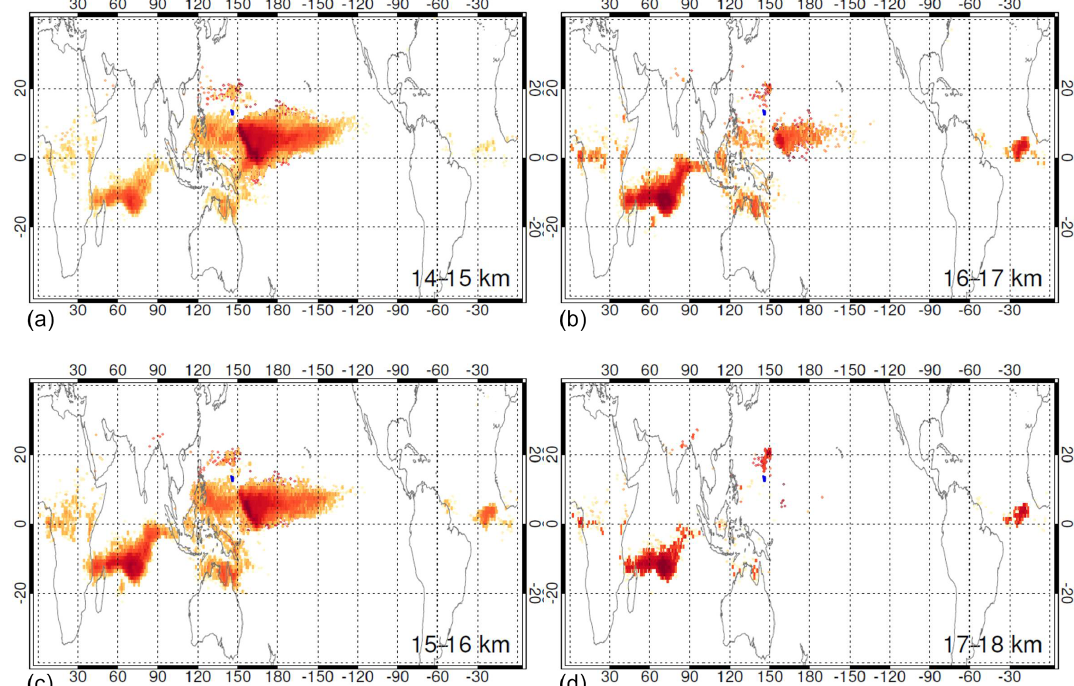
Figure 3. Crossing location distribution maps for all the NAME runs released from four 1km TTL altitudes between 14 and 18km. Strong influence of local boundary air is noted for a 14–15km segment (lower TTL), whereas the boundary air from remote locations dominates for a 17–18km segment (upper TTL), research flight 02, ATTREX 2014.